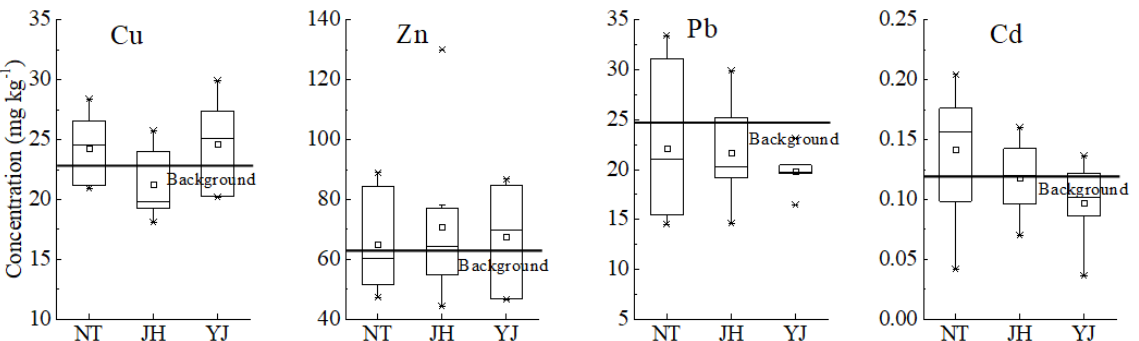
Figure 3. Heavy metal concentrations at the depth of 0–5 cm in highway-side soils and the corre- sponding background values. (The black bold lines are the background values of corresponding elements. NT, Ningtong expressway; JH, Jinghu expressway; YJ, Yanjiang expressway. The inter- quartiles from bottom to top in the box are 25%, 50% and 75% of the data, respectively. The small square is the average value. The two endpoints of the bar are minimum and maximum values, re- spectively. The asterisks are the outliers.)